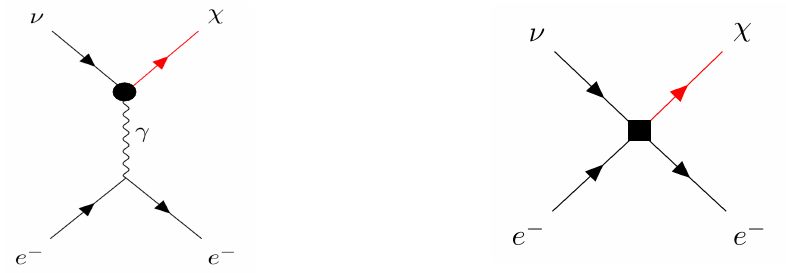
Figure 1 . The tree-level Feynman diagrams for the ν α + e − → χ + e − process, where the circular bulb (square) represents the effective dim-5 dipole (dim-6 four-fermion)